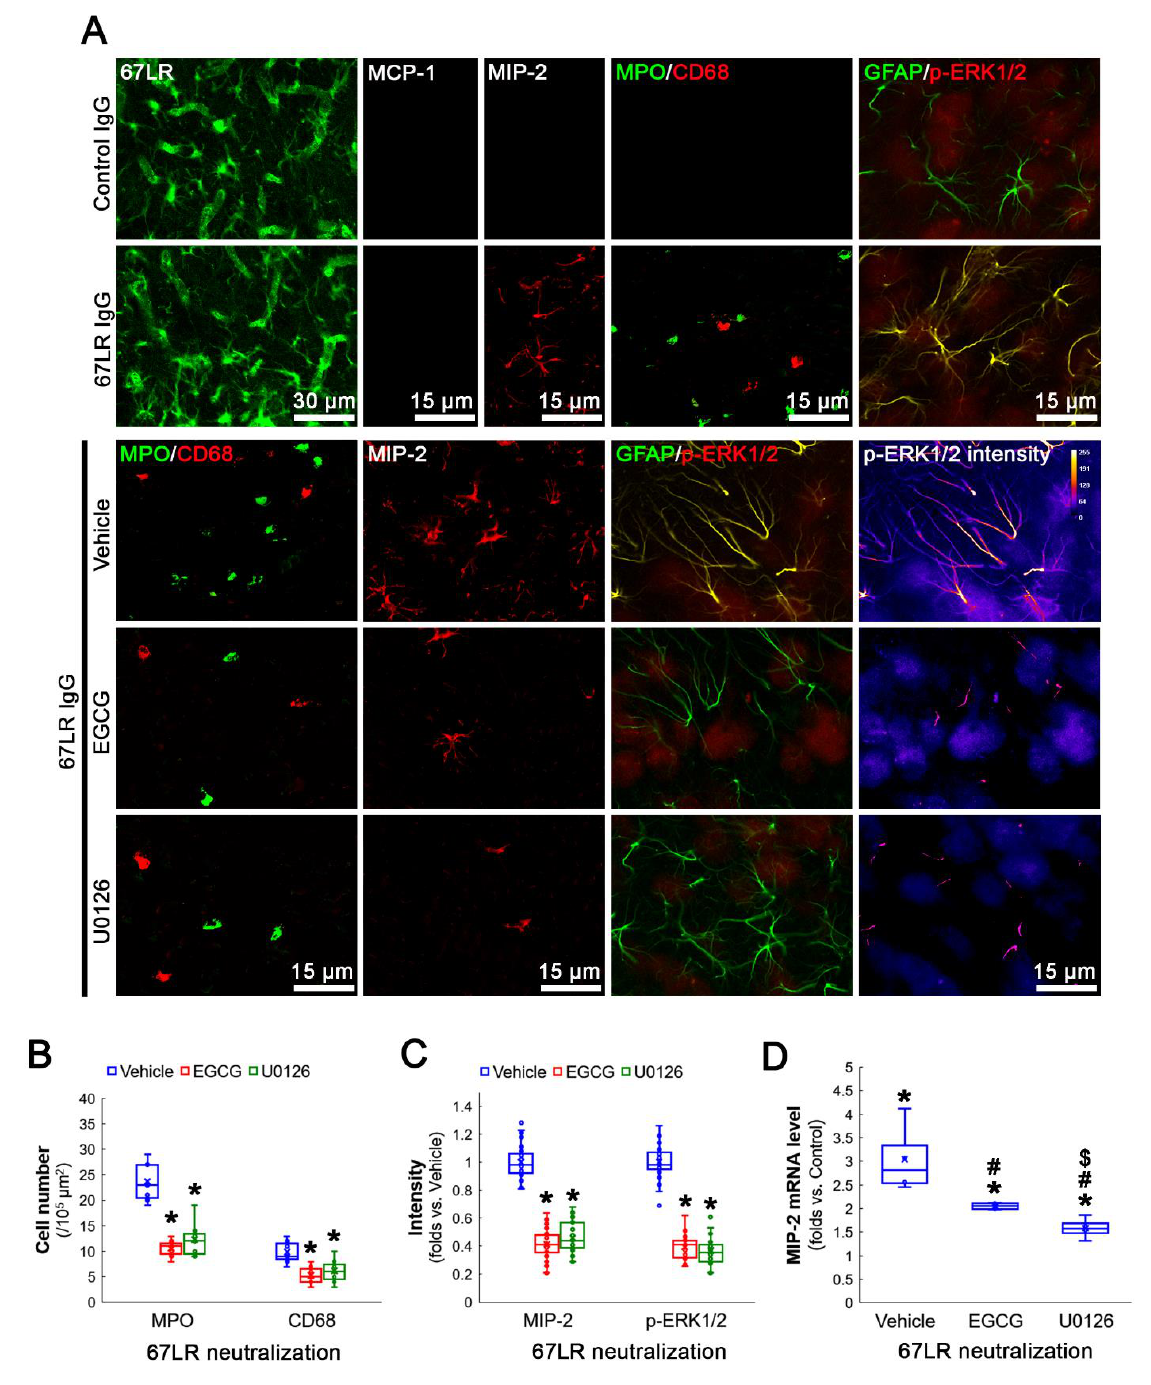
Figure 7. Effects of 67LR neutralization and co-treatment of EGCG or U0126 on leukocyte infiltration, MIP-2 expression and p-ERK1/2 level in the FPC under physiological condition. Although 67LR neutralization does not alter 67LR expression, it induces MIP-2 induction, leukocyte infiltration and p-ERK1/2 upregulation in the FPC without MCP-1 induction, which are ameliorates by co-treatment of EGCG or U0126. ( A ) Representative photos of 67LR, MCP-1, MIP-2 and p-ERK1/2 expressions in the FPC induced by 67LR neutralization. ( B ) Quantification of the number of infiltrating leukocytes. * p < 0.05 vs. vehicle co-treatment ( n = 7 rats, respectively). ( C ) Quantification of MIP-2 and p-ERK1/2 levels in astrocytes. * p < 0.05 vs. co-treatment ( n = 40 cells in 7 rats, respectively). ( D ) Quantification of the MIP-2 mRNA in the hippocampus. * ,#,$ p < 0.05 vs. control, vehicle and EGCG, respectively ( n = 4 rats, respectively).